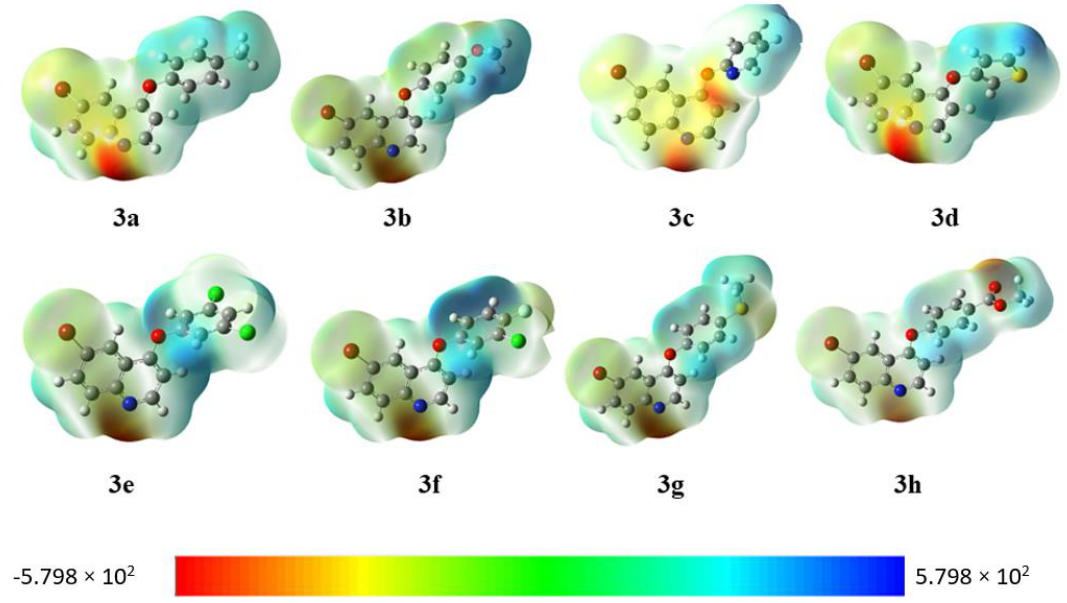
Figure 8. Molecular electrostatic potential surfaces of compounds 3a – 3h.